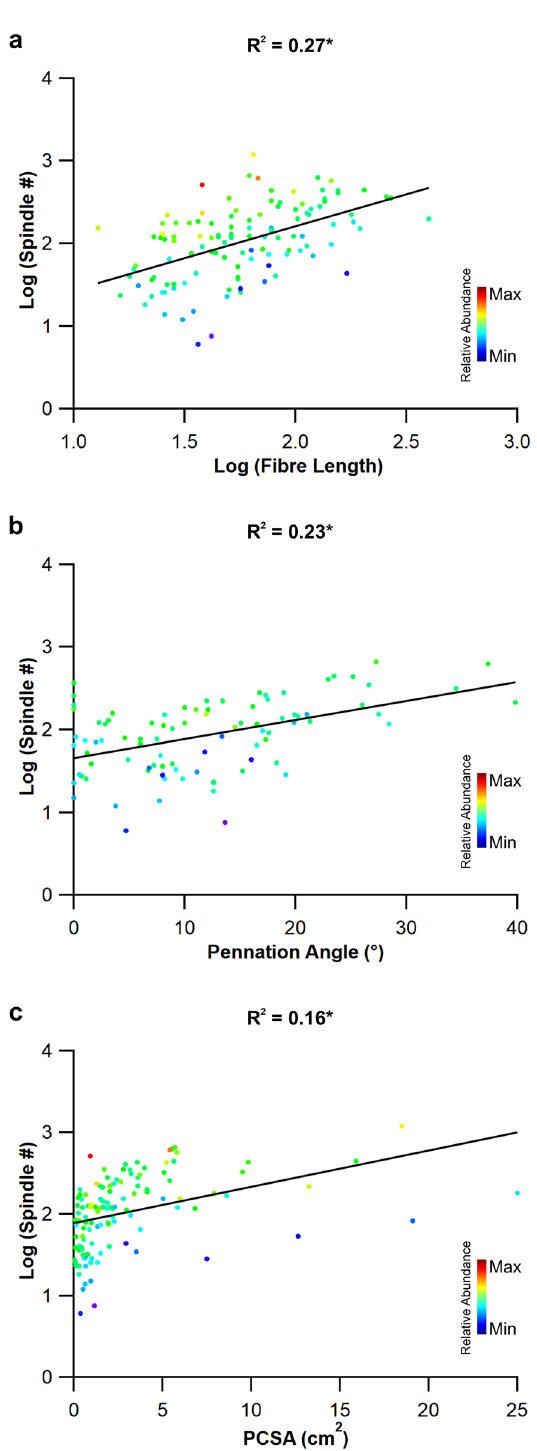
Figure 1. Muscle spindle number correlates with fibre length, muscle pennation and physiological cross- sectional area. Spindle number is correlated with muscle fibre length ( a ), muscle pennation ( b ) and muscle physiological cross-sectional area ( c ). Muscle spindle abundance as indicated by the heatmap highlights that neither fibre length, muscle pennation nor physiological cross-sectional area correlated with muscle spindle abundance. * P <